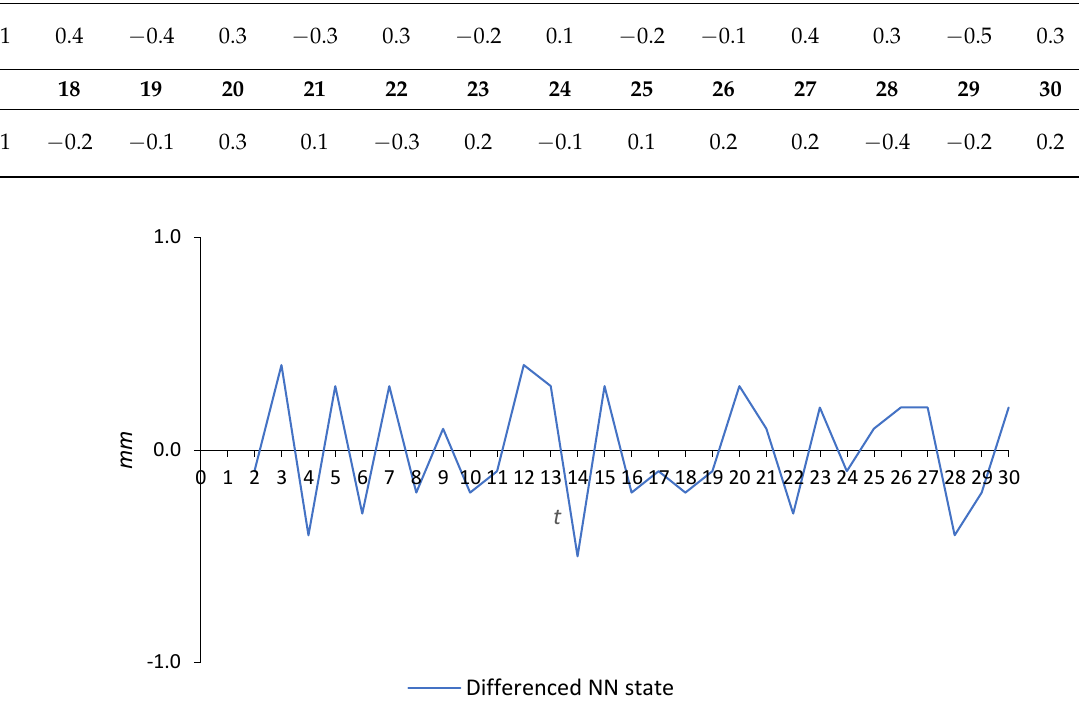
Table 10. Transformation from MD stationary to NN state of series